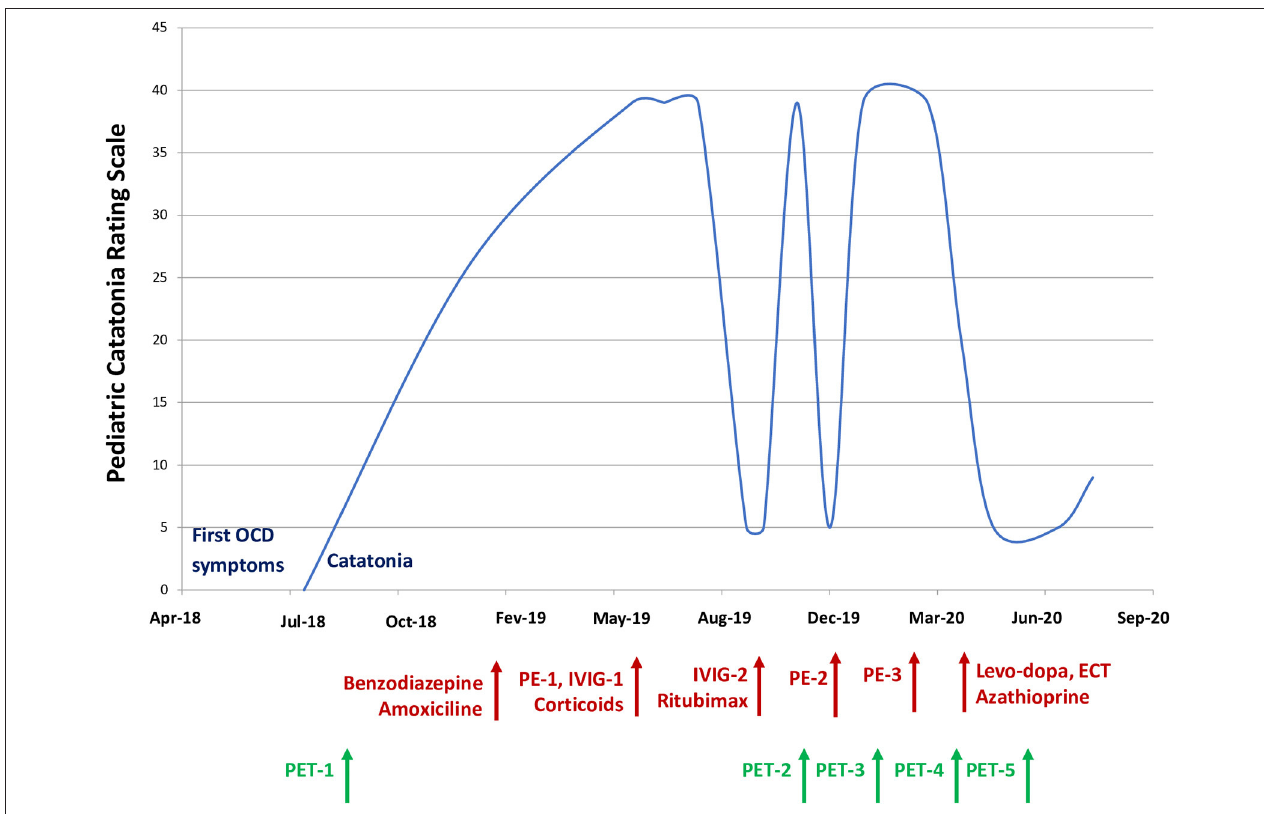
FIGURE 2 | Pediatric catatonia rating scale based on time and treatment during the 2-year follow-up. OCD, obsessive compulsive disorder; PE, plasma exchanges; 18 F-FDG PET, 18-fluorodeoxyglucose positron emission tomography; IVIG, intravenous immunoglobin; ECT, electroconvulsive